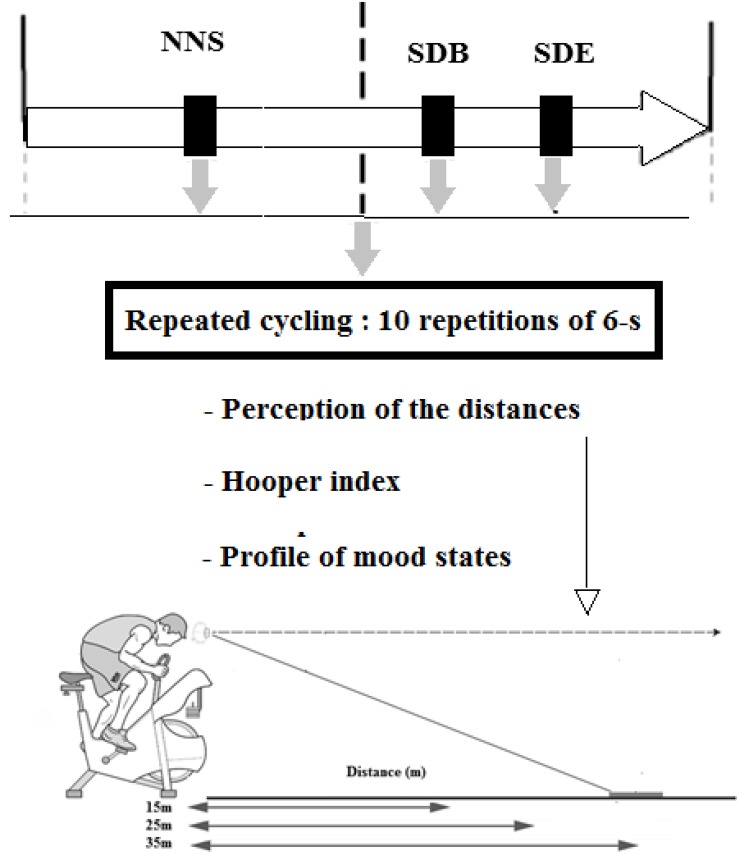
Experimental protocol. NNS, normal sleep night; SDB, sleep deprivation at the beginning of the night; SDE, sleep deprivation at the end of the night.